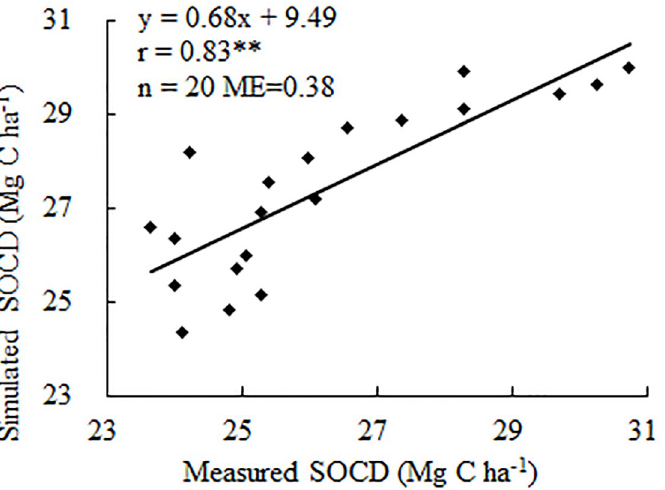
Fig 2. The relationship between measured and simulated SOCD at Yushu site, Jilin Province, China. �� Significant P < 0.01level. ME = modeling